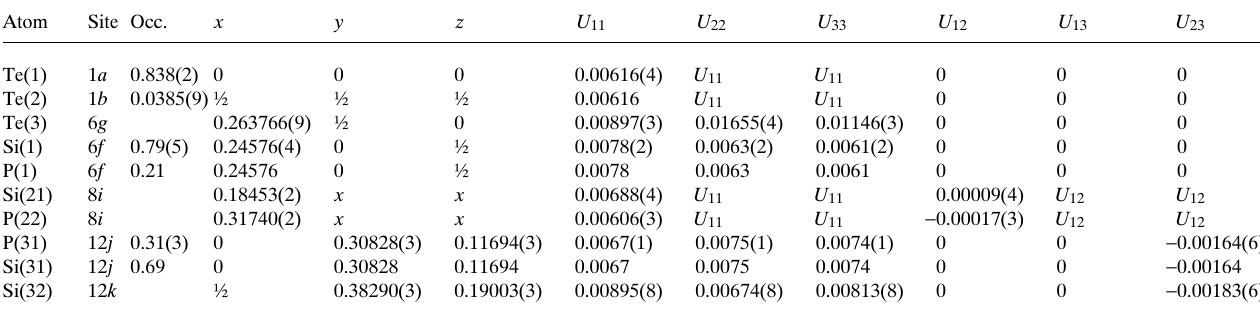
Table 6. Atomic coordinates and displacement parameters (in Å 2 ) . Atom Site